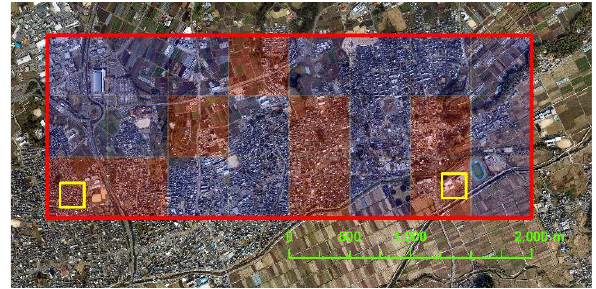
Figure 1 . Aerial imagery of the study area.